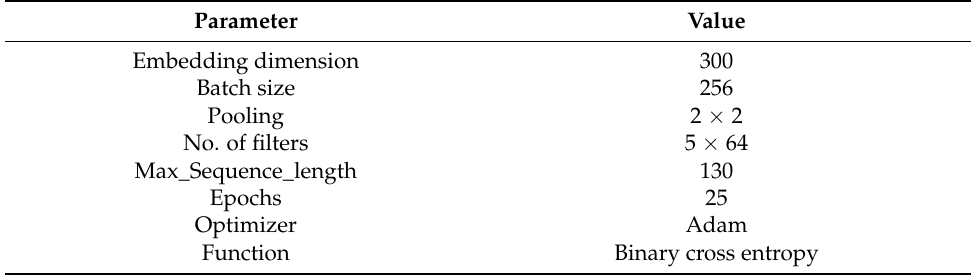
Figure 3. CNN-based Deep Learning Architecture. Table 3. Summary of hyper-parameter values for